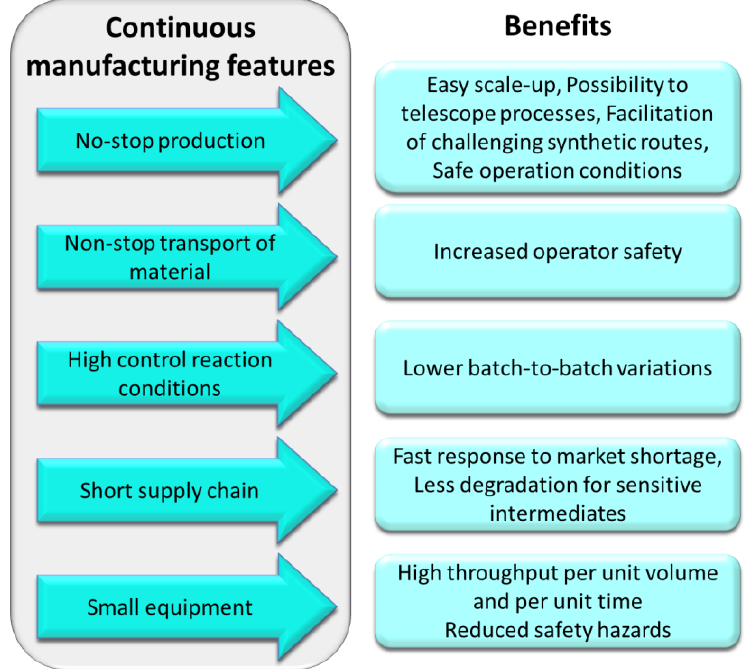
Figure 2. Summary of advantages of flow chemistry relevant to industrial applications.